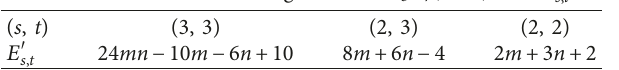
5 C 7 (2, 4) by E s,t . 5 C 7 ( m , n ) into